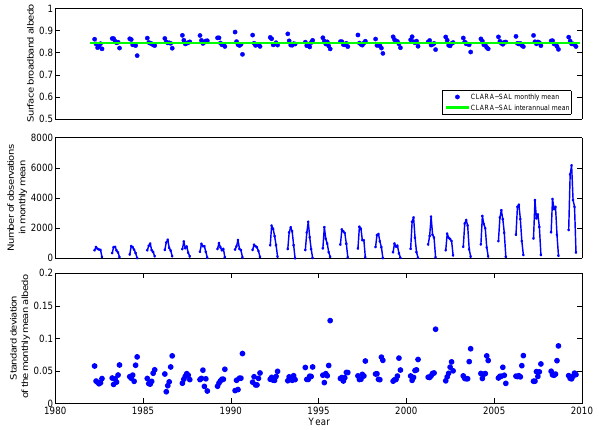
Fig. 10. (a) illustrates the monthly means of surface albedo over 28 years, averaged over the central part of GrIS. The thick green line shows the interannual mean albedo of the region. (b) shows the mean number of AVHRR overpasses in each monthly mean in (a) , averaged over the study region. Finally, (c) shows the mean standard deviation of each monthly mean in (a) , averaged over the study region.